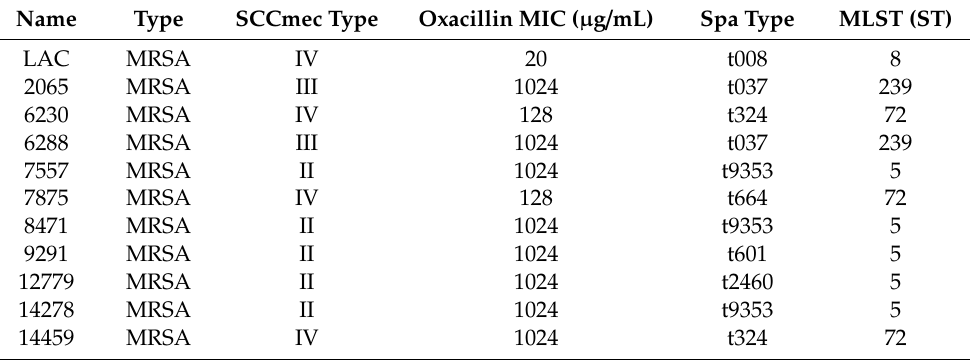
Figure 3. Effect of oxacillin on clinically isolated strains. ( A ) Effect of different oxacillin concentrations on the cell growth of clinical strains. ( B ) Effect of different oxacillin concentrations on the biofilm formation of clinical strains. The strains were classified into three groups: the high ‐ resistance (MRSA8471 and MRSA9291), intermediate ‐ resistance (MRSA2065, MRSA6288, MRSA7557, MRSA12779, MRSA14278, and MRSA14459), and sensitive (MRSA6230 and MRSA7875) groups. The error bars represent the standard deviation of three replicates for all strains. The averages of cell growth and biofilm for each group were calculated, and the results are simplified in the figures. Table 5. Types of clinically isolated strains and oxacillin minimum inhibitory concentration (MIC) as well as their